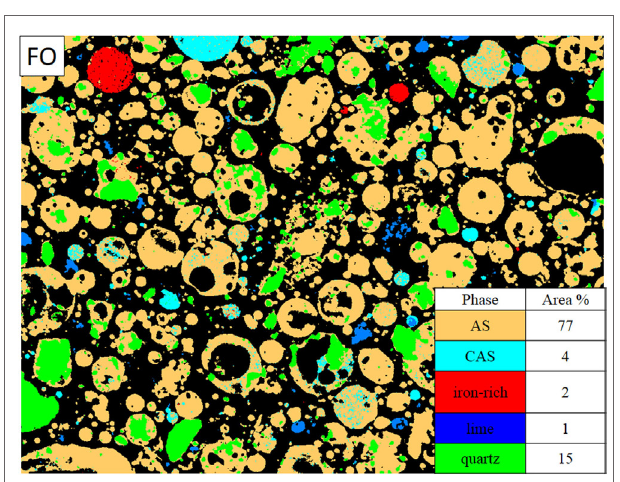
FigUre 4 | Phase assignment image of FO fly ash.